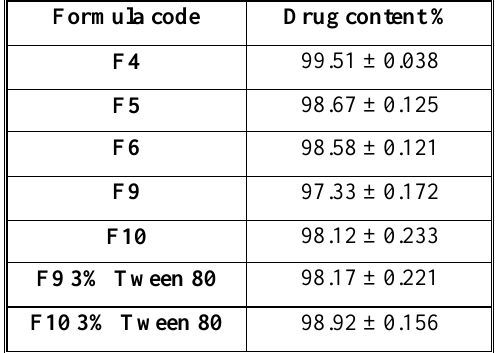
Table 4. The Percent of Drug Content of MN